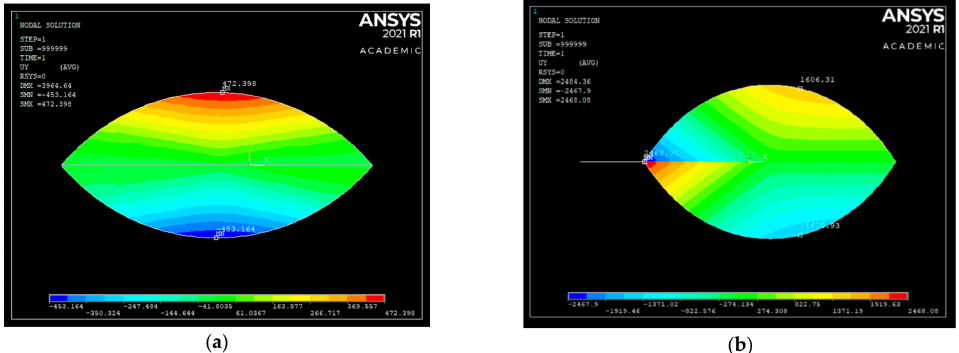
Figure 23. (Above) ( a ) Sliding mechanism post FEM analysis contour plot of the displacement of the structure ‘y’ direction from the highest displacement in the positive direction (in red) and the highest displacement in the negative direction (displayed in µ m). ( b ) Zipping mechanism post FEM analysis contour plot of the displacement of the structure ‘y’ direction from the highest displacement in the positive direction (in red) and the highest displacement in the negative direction (displayed in um).